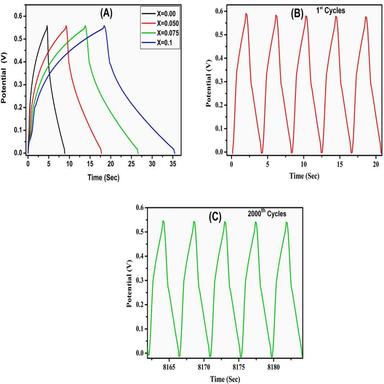
(a) Galvanostatic Charge-Discharge curve of CoFe2-xSmxO4 (x = 0.0, x = 0.050, x = 0.075 and x = 0.1 ferrites. (b). Galvanostatic Charge-Discharge curve of CoFe2-xSmxO4 for x = 0.1 (1st Cycle) (c). Galvanostatic Charge-Discharge curve of CoFe2-xSmxO4 for x = 0.1 (2000th Cycle) ferrites.